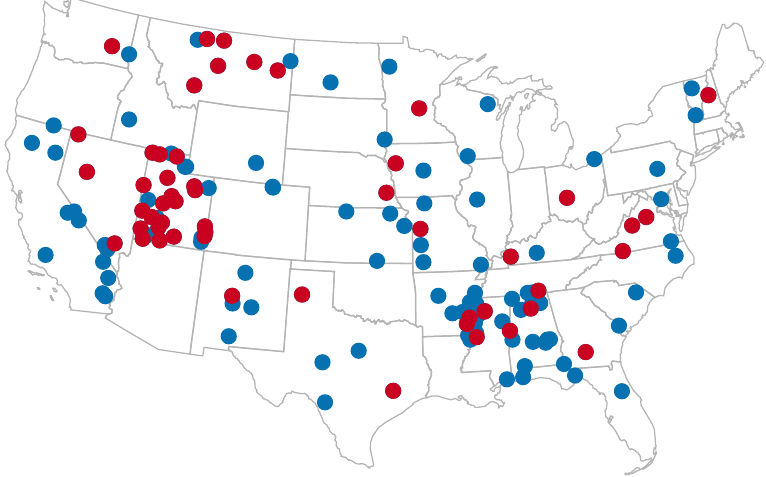
Figure 1. Locations of the selected Service Soil Climate Analysis Network (SCAN)-sites (dots) used for validating the Copula-combined (Co)SMOP brightness temperatures. The blue dots depict stations with at least one year of observations during both the calibration and validation period; the red dots indicate stations that cover at least 80% of both